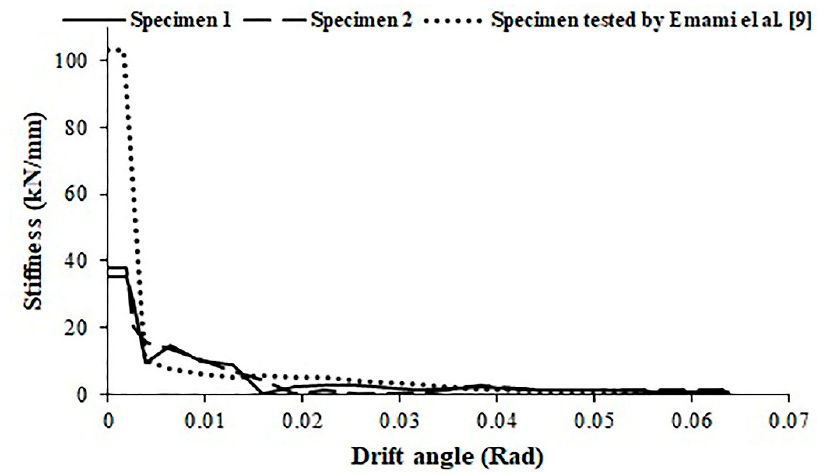
Figure 14. Stiffness performance of studied specimens.